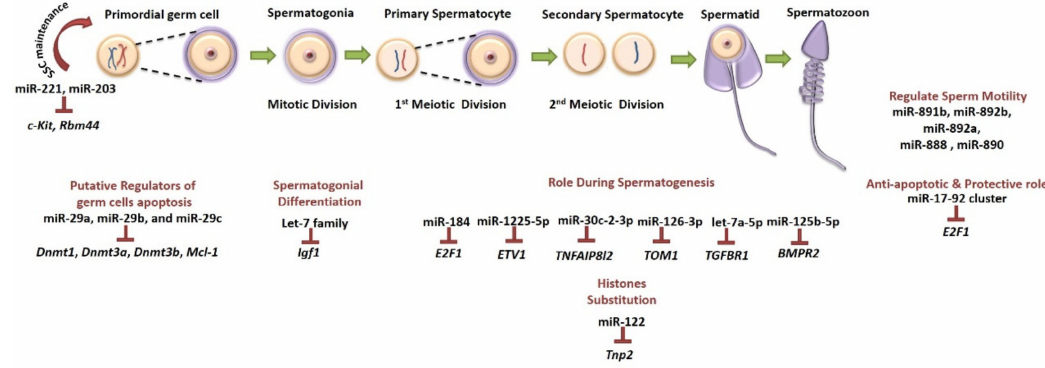
Figure 3. SchematicrepresentationofselectedmiRNAsexpressedduringtheseveralstagesofdevelopment and maturation of male germ cells. Targeted genes and their functions are indicated. miR-221 and miR-203 contribute to SSC maintenance [83] while members of let-7 family regulate spermatogonial differentiation [84]. Several miRNAs (miR-122, miR-184, miR-1225-5p, miR-30c-2-3p, miR-126-3p, let-7a-5p and miR-125-5p) and their targets have been identified to have a critical role during spermatogenesis [85] and histone remodeling (miR-122) [86]. Moreover, miRNAs have been identified in germ cell apoptosis (miR-29 family) [79] and others have an anti-apoptotic role (miR-17-92) [77], whereas some miRNAs can modulate sperm characteristics like motility (miR-891b, miR-892b, miR-892a, miR-888 and miR-890) [87]. Inverted T bars indicate the targeted